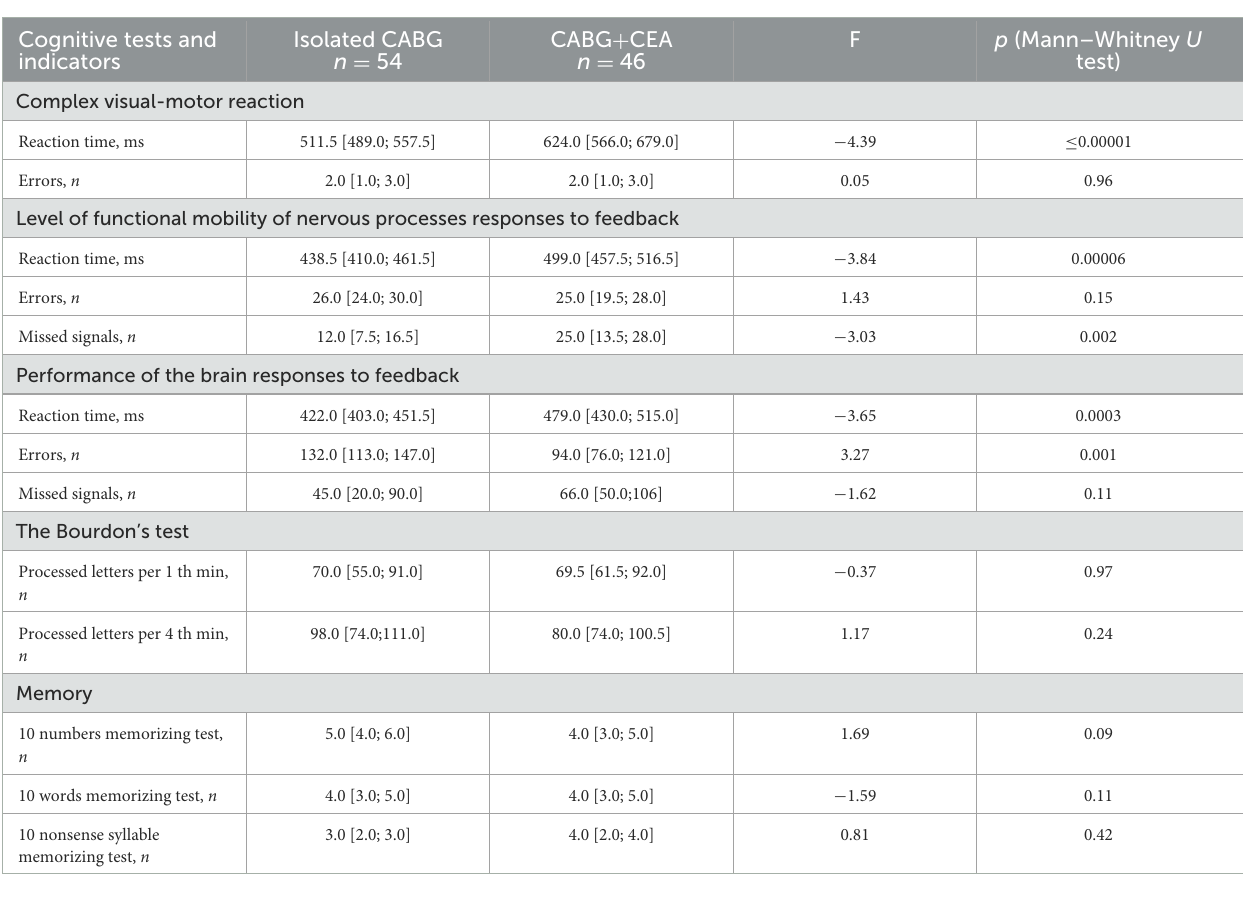
TABLE 4 Cognitive indicators in the patients after cardiac surgery.